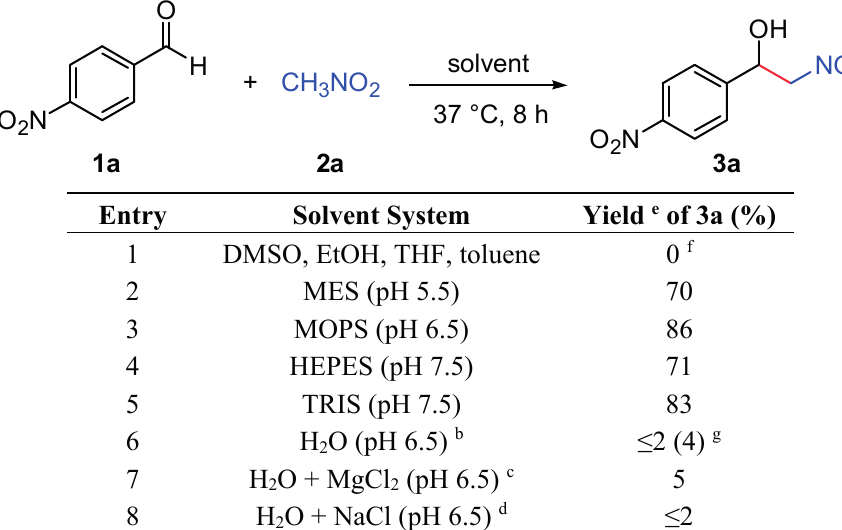
Table 1. Effect of solvent in the model nitroaldol reaction between 1a and 2a . a O OH solvent NO H 2 + CH NO 3 2 37 °C, 8 h O N 2 O N 2 1a 2a 3a Entry Solvent System Yield e of 3a (%) 1 DMSO, EtOH, THF, toluene 0 f MES (pH